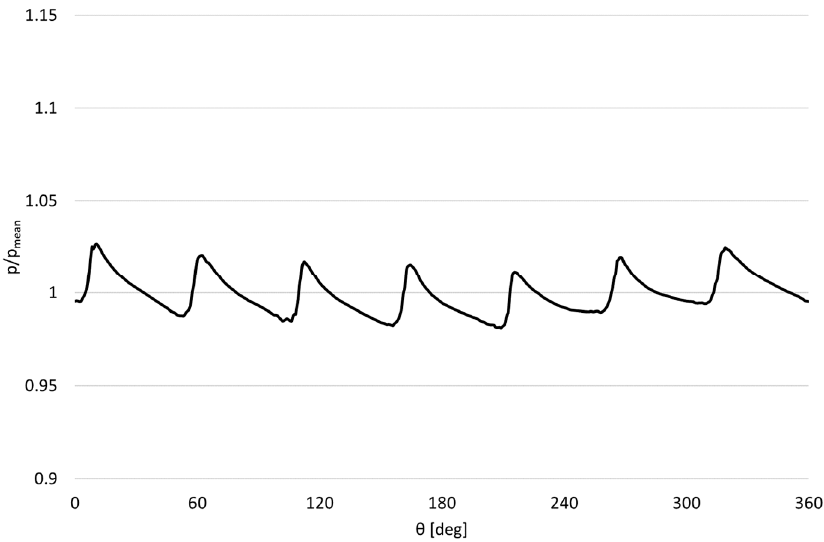
Figure 18. Pressure over the mean pressure ( p/p mean ) along the mean radius at the trailing edge of the blade at the BEP.